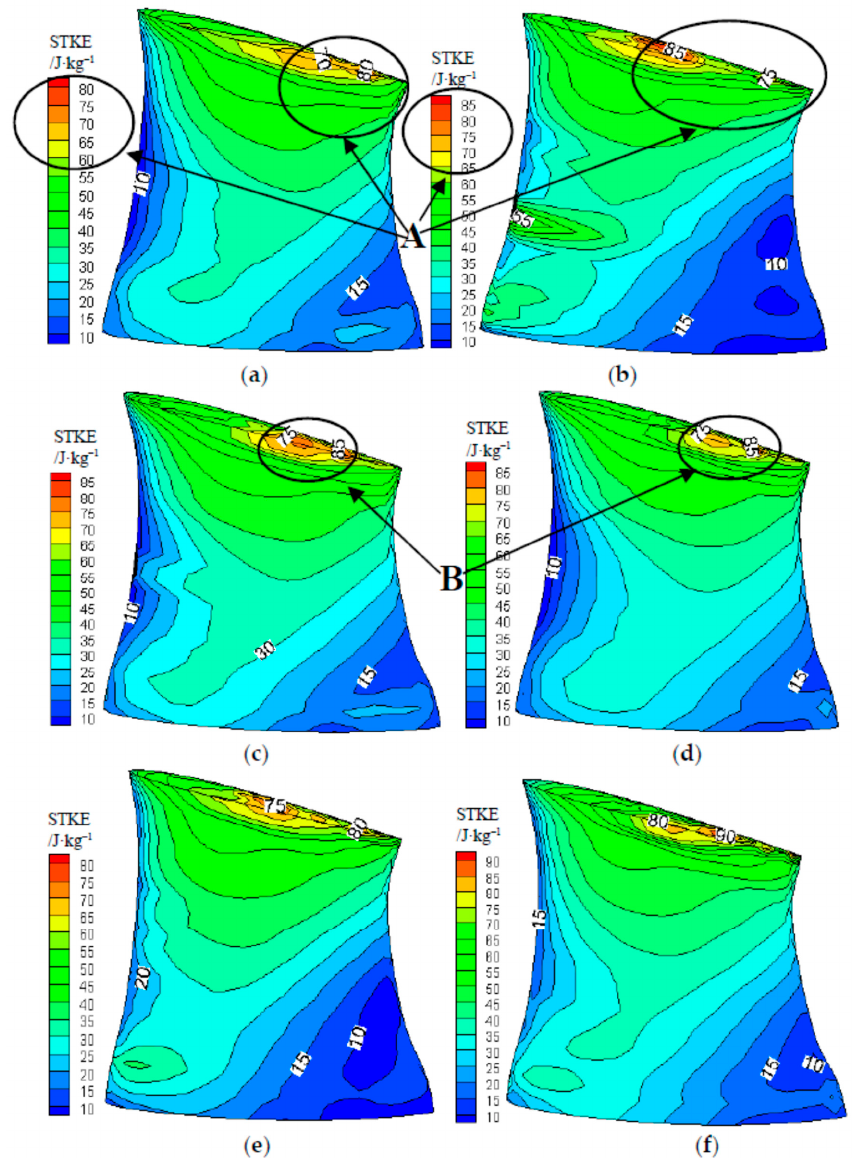
Figure 14. Specific turbulent kinetic energy (STKE) distribution on the surface of forward-skewed and original blades with different blade pitch angles. ( a ) β = 29°, θ = 0°; ( b ) β = 29°, θ = 3.0°; ( c ) β = 32°, θ = 0°; ( d ) β = 32°, θ = 3.0°; ( e ) β = 35°, θ =0; ( f ) β = 35°, θ = 3.0°.